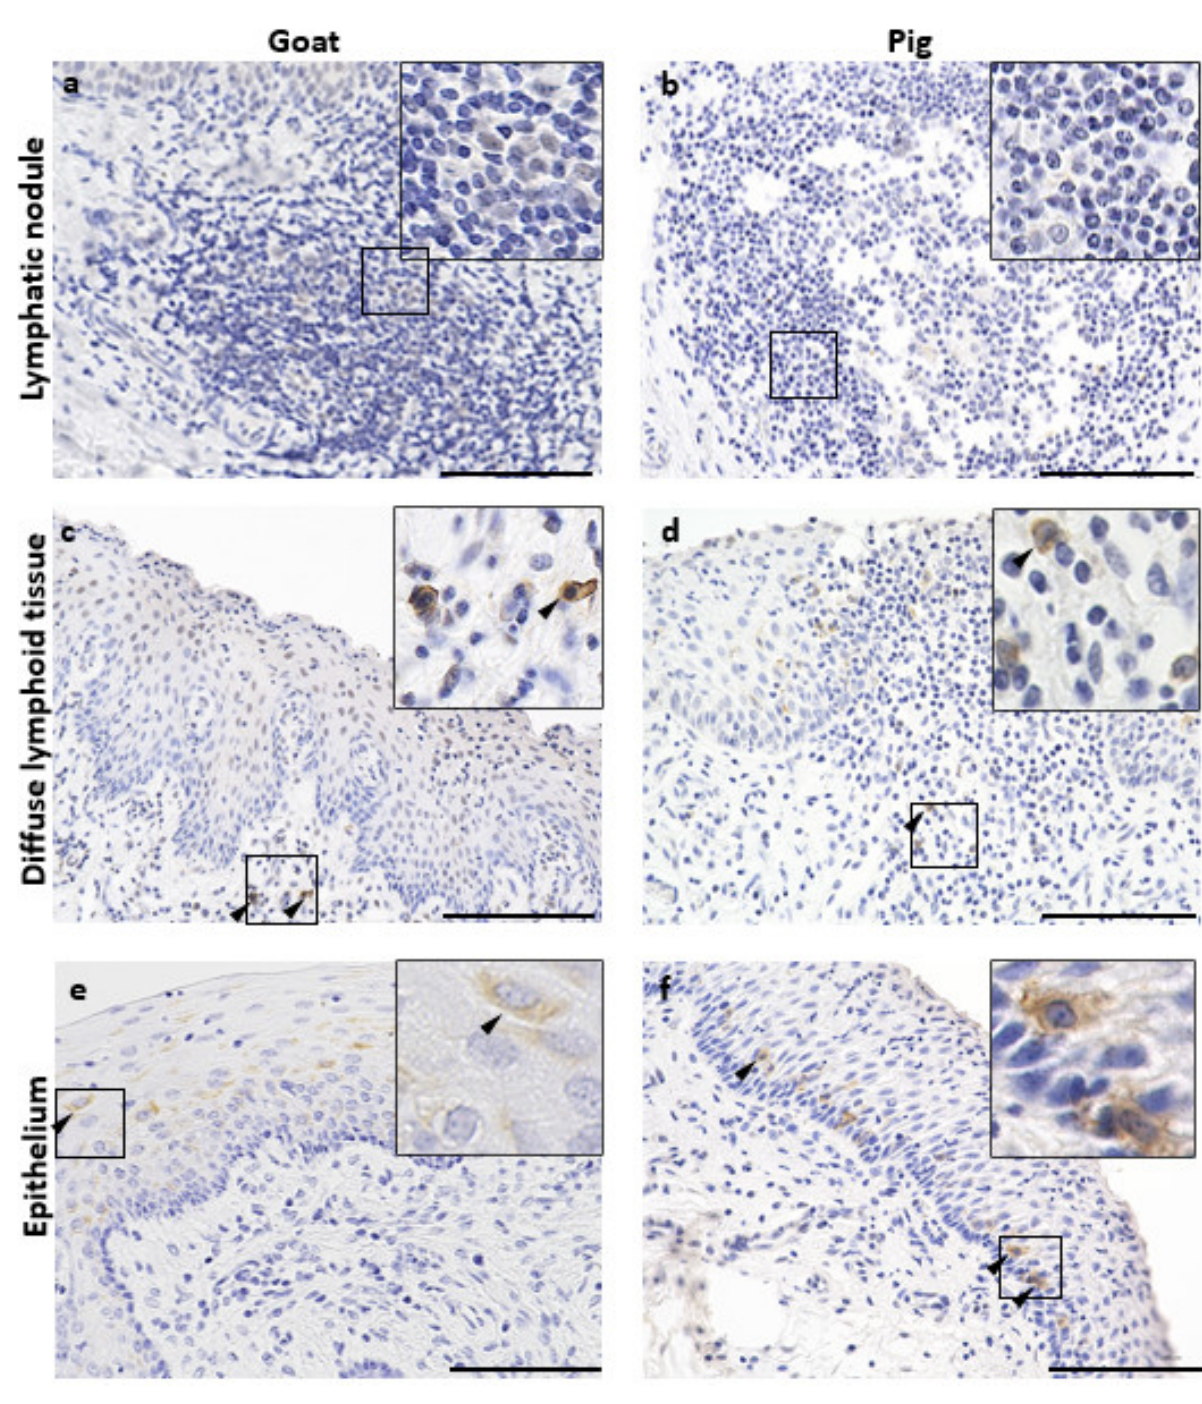
Figure 6. Dendritic cells characteristic in GOALT and epithelium of VV of goat and pig. ( a , b ) Langerin + cells in the LN of goat and pig. ( c , d ) Langerin + cells in the DLT of goat and pig. ( e , f ) Langerin + cells in the of goat and pig. Black arrowheads show positive reaction for IHC. Scale bars = 100 μm.